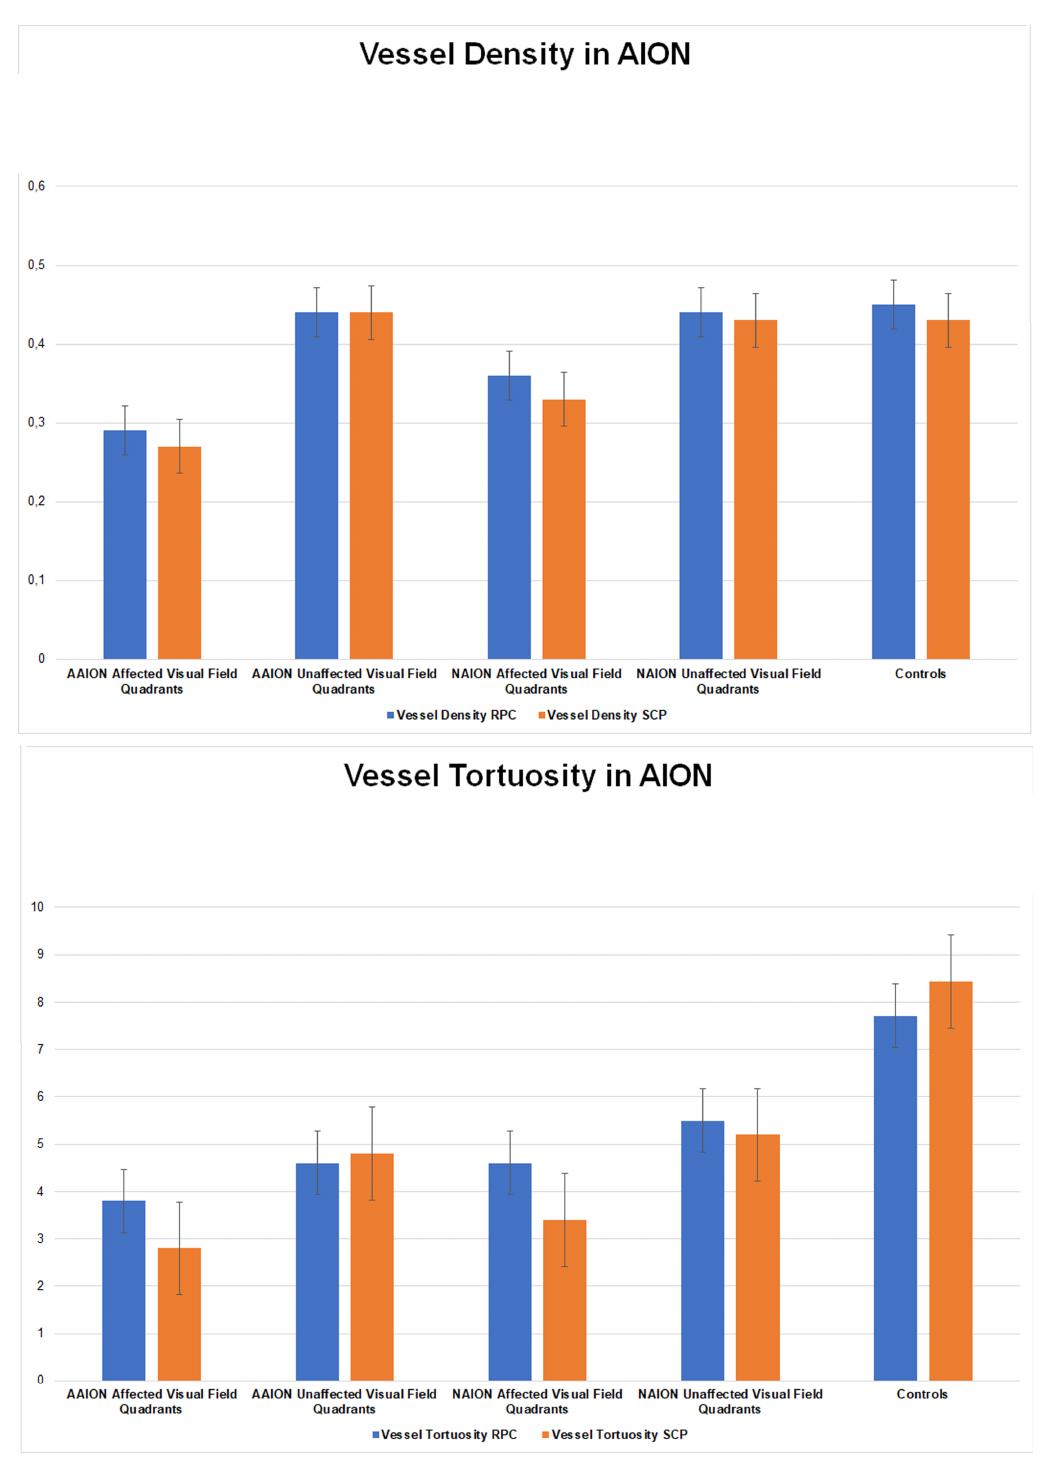
Figure 3. Bar graphs of vessel density and vessel tortuosity values in a ff ected and una ff ected quadrants of AAION and NAION patients. ( A ). Vessel Density in AION, ( B ). Vessel Tortuosity in